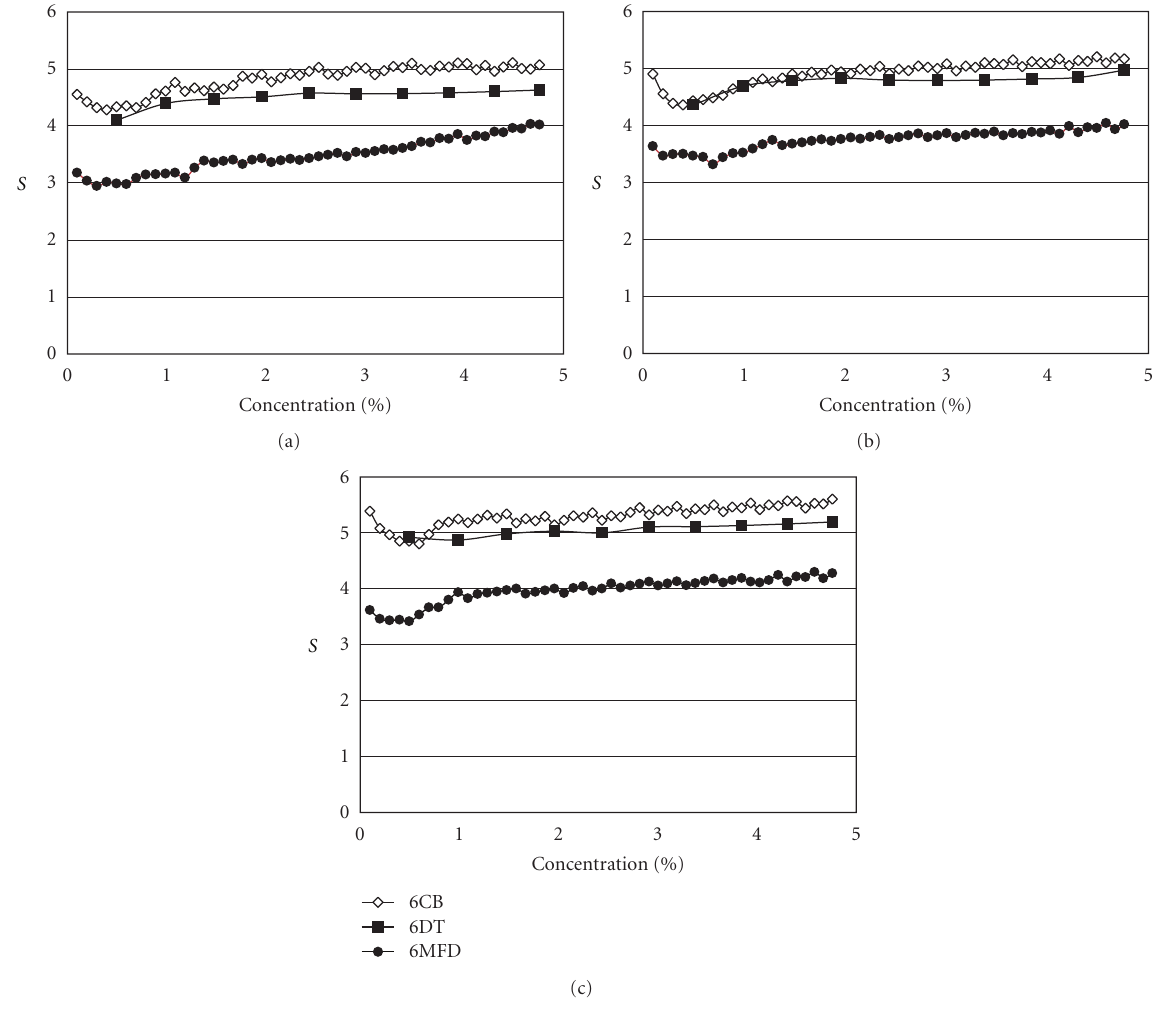
Figure 14: S values versus concentration (%), at varying impeller geometries. (a) size of activated carbon 1.40–2.36 mm, (b) size of activated carbon 1.00–1.40 mm, and (c) size of activated carbon 0.75–1.00